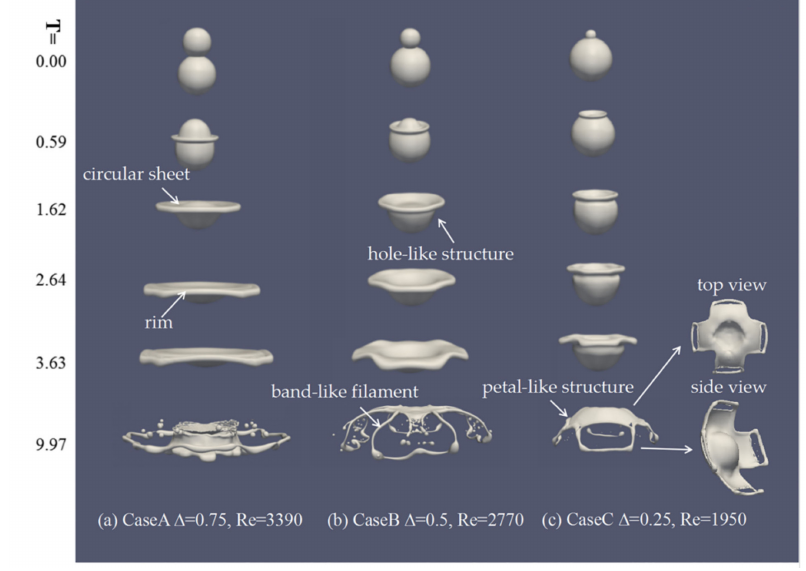
Figure 4. Temporal evolution of droplets’ deformation under the di ff erent size-ratios of 0.75, 0.50, and 0.25 at We =